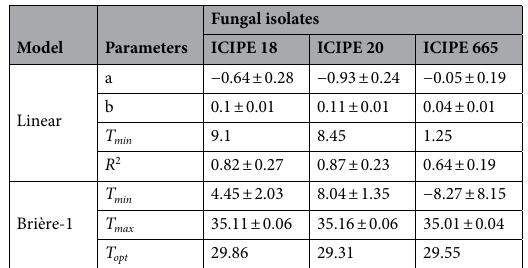
Table 1. Estimated parameters and their approximative standard errors for linear and Brière-1 nonlinear model describing the relationship between temperature and growth of Metarhizium ansiopliae isolates.